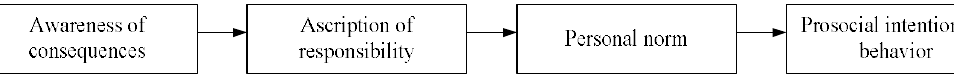
Figure 2. The framework of norm activation model.